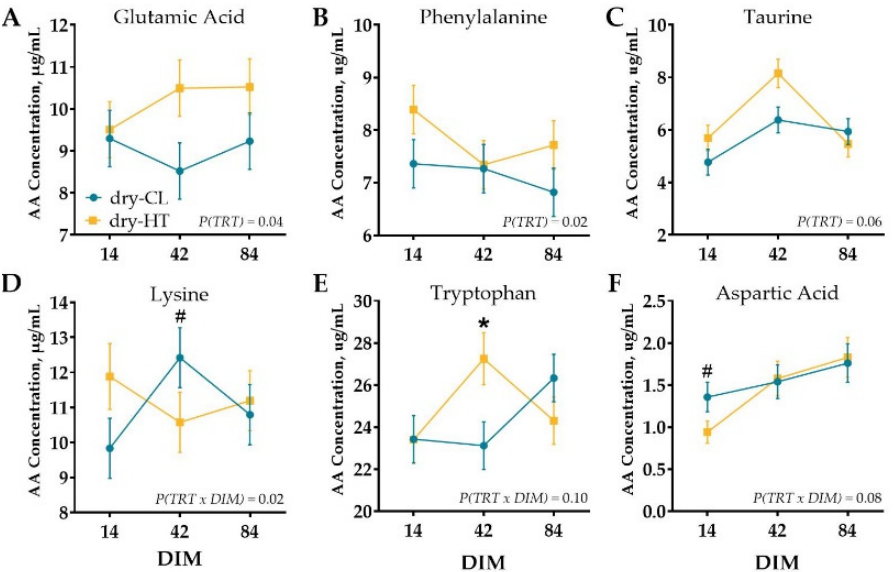
Figure 2. Plasma free AA concentration at 14, 42, and 84 days in milk (DIM). Cows were exposed to dry period heat stress (dry-HT, n = 5) or cooling (dry-CL, n = 5) for 46 days pre-calving. Blood was collected at 14, 42, and 84 DIM, and plasma was analyzed for free AA concentration. Amino acids that differed between treatments (TRT, A – C ) or treatment × DIM interaction ( D , F ) are depicted with significant contrasts denoted by * ( p ≤ 0.05) or # (0.05 < p ≤ 0.10). All data are presented as least square means ± standard error of the treatment × time interaction.